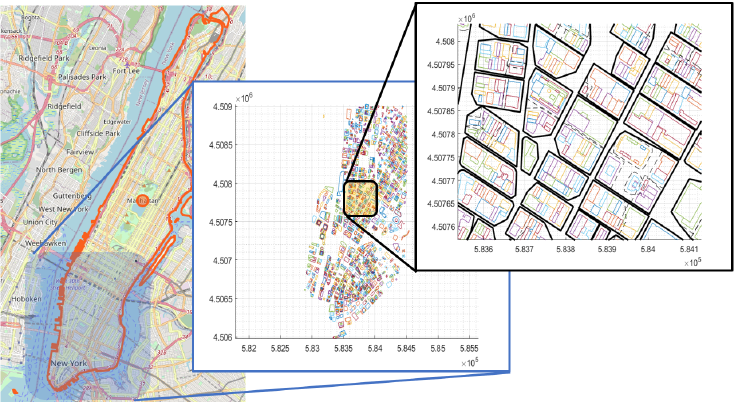
Figure 8. Post-processing map data for southern Manhattan. Buildings with heights greater than 20 m are shown. The rightmost plot shows keep-out geofences enclosing building clusters (black solid lines), individual building keep-out geofences (black dashed lines), and building outlines (colored lines). Geofence maps for 60 m, 122 m, and 400 m altitude cross-sections are constructed in the same manner.